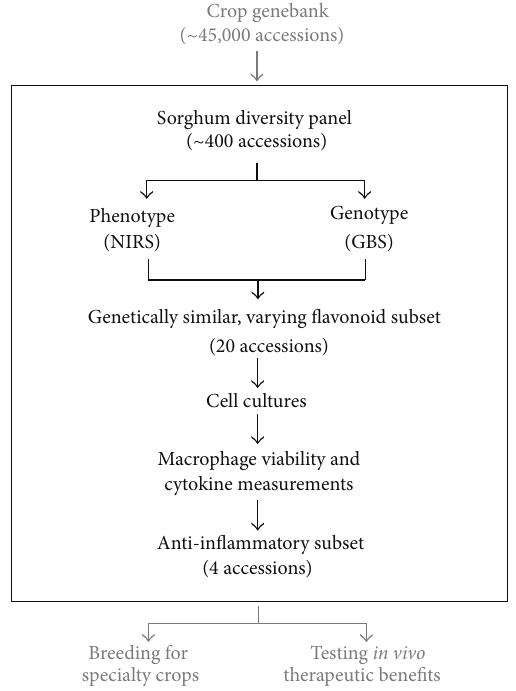
Figure 5: Workflow for screening and testing a large sorghum germplasm panel. 381 accessions were selected from a sorghum genebank, grown in South Carolina, and evaluated for polyphenol concentrations and relatedness. Twenty accessions were selected for in vitro testing. Four accessions were identified that reduce induction of inflammatory